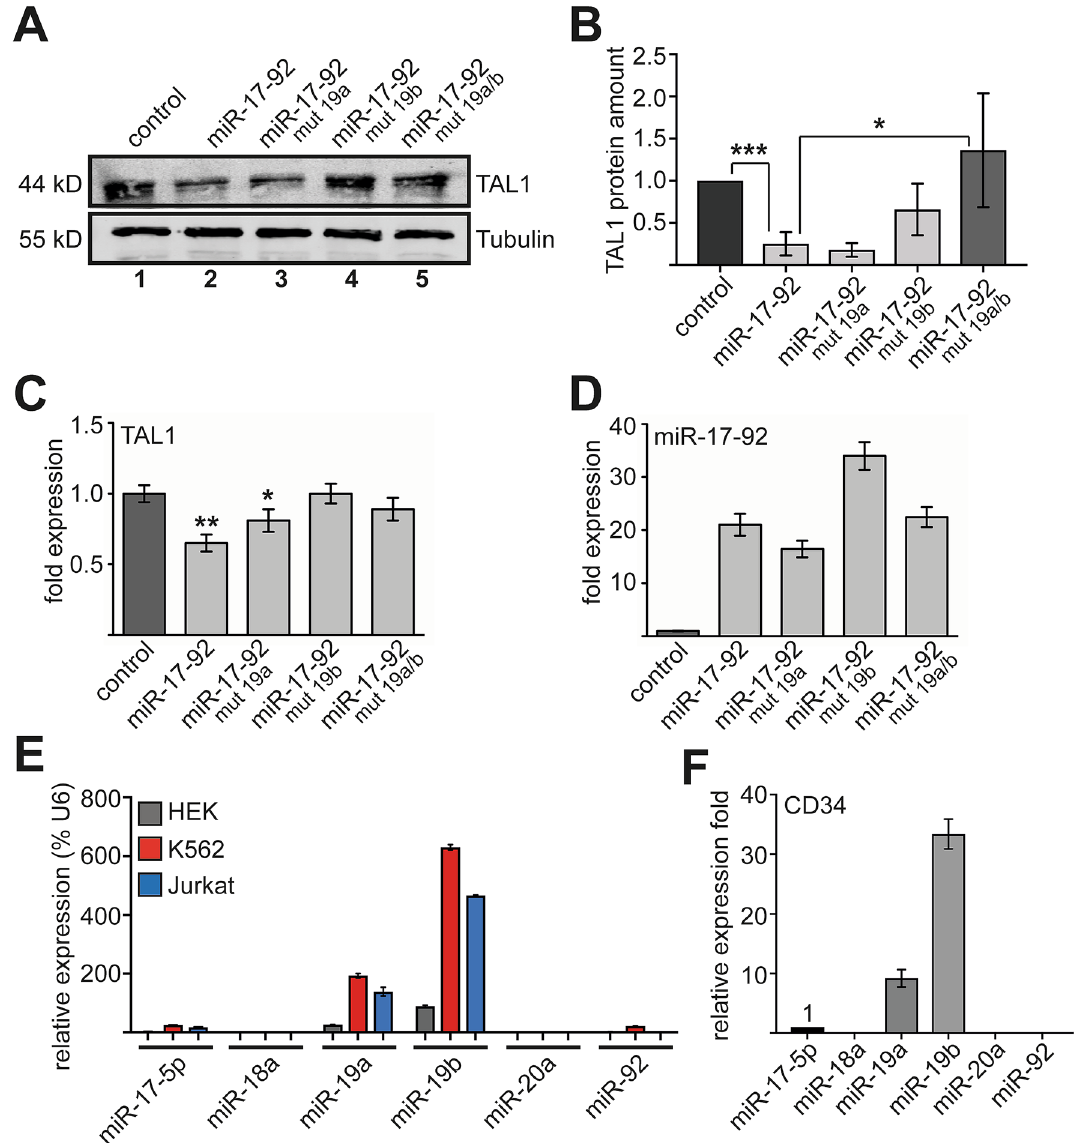
Figure 3. The repressive effect of miR-17-92 on TAL1 is lost by mutation of the miR-19 seed sequences. ( A ) Western blot showing the effect of miR-17-92 wild type and mutants on TAL1 protein amount. TAL1 protein amount was reduced upon transduction of miR-17-92 compared to transduction with control vector in Jurkat cells (compare lane 1 to lane 2). The seed sequences of miR-19a and miR-19b of the miR-17-92 cluster were mutated, respectively. Western blot analysis showed that the inhibiting effect of miR-17-92 on TAL1 was lost after mutation of miR-19b and a double mutation of miR-19a/b (lane 4 and lane 5). ( B ) Quantification of TAL1 protein levels by western blot analysis using the Odyssey system. Relative protein amounts are shown compared to values gathered upon transduction with empty vector. ( C ) Quantification of TAL1 mRNA levels by qRT-PCR upon transduction of miR-17-92 wild type and mutants compared to transduction with control vector in Jurkat cells. Data were normalized to expression of GAPDH and values are displayed as fold expression compared to the empty vector control. Evaluation was performed three times. ( D ) Overexpression levels of miR-17-92 wild type and mutant constructs were determined by qRT-PCR. Primers against unprocessed miR-17-92 were used. Values were normalized to expression levels of GAPDH and are shown as fold expression compared to cells transduced with empty vector. ( E ) Expression levels of the six mature members of the miR-17-92 cluster were analysed using the “Real-Time PCR Assay Kit” (Signosis). Mature miR-19a and miR-19b show the highest expression in HEK, K562 and Jurkat cells. Data are shown in percent relative to values gathered for RNUB6 (U6). ( F ) Expression levels of the six mature members of the miR-17-92 cluster in CD34 + cells were analysed using the “Real-Time PCR Assay Kit” (Signosis). CD34 + cells show high expression of miR-19a and the even higher expression of miR-19b. Values are shown as fold expression compared to miR-17-5p expression, which was set as one. Error bars were calculated using standard deviation from at least three independent values. The p-values were calculated using Student’s t-test from at least three independent measurements. *P < 0.05; **P <